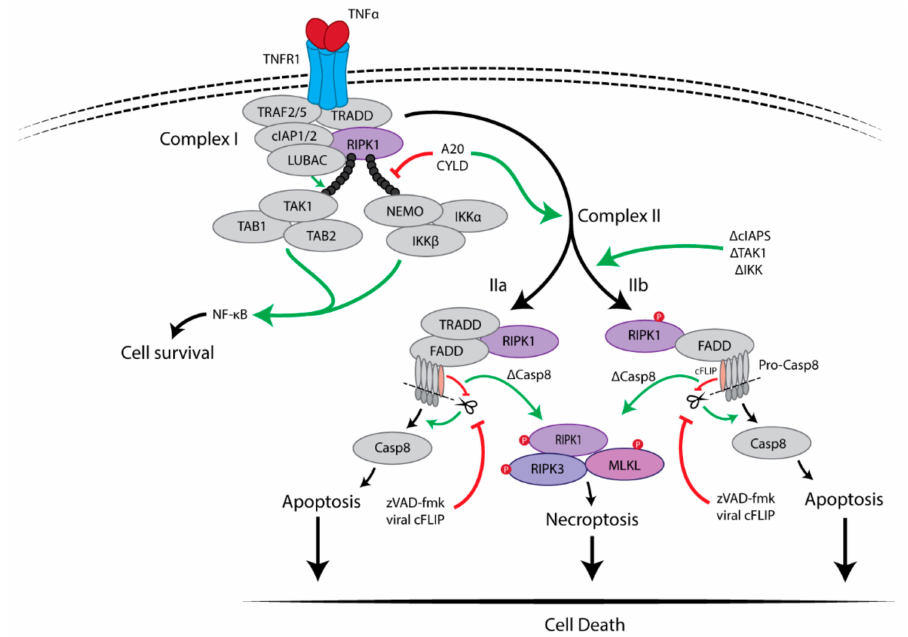
Figure 1. TNFR1-mediated survival and cell death pathways. The binding of TNF α to TNFR1 triggers multiple signaling pathways, including NF- κ B, apoptosis and necroptosis. Upon stimulation, TNF α induces the formation of a membrane-associated complex I, which consists of RIPK1, TRADD, TRAF2 / 5, LUBAC and cIAP1 / 2. Within complex I, cIAP1 / 2 and LUBAC induce Lys63-linked polyubiquitination of RIPK1. The polyubiquitin chain of RIPK1 serves as a sca ff old for further recruitment of IKK (IKK α , IKK β and NEMO) and TAK1(TAK1, TAB1 and TAB2) complexes, eventually leading to activation of NF- κ B pathway and cell survival. Deubiquitination of RIPK1 by CYLD or A20 induces the dissociation of TRADD and RIPK1 from TNFR1, which leads to the formation of either of complex IIa or complex IIb. FADD and pro-caspase-8 are recruited to TRADD and RIPK1 to form complex IIa, resulting